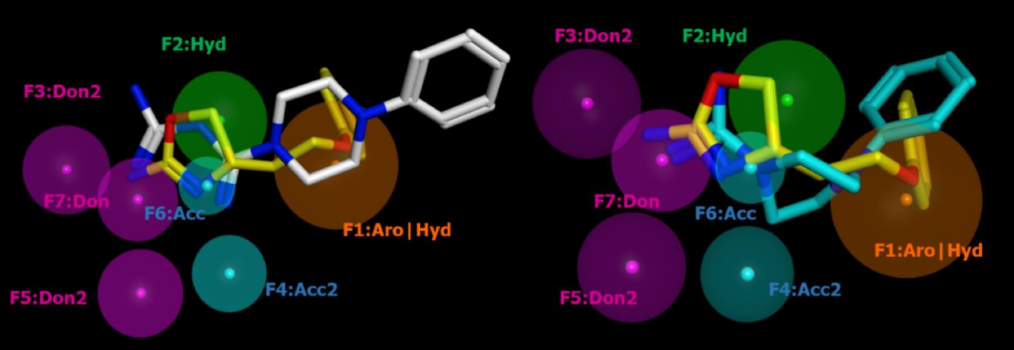
Figure 7. Pharmacophore features shared by most of the oxazolines acting as h TAAR1 agonists (Table S1). The most potent derivative 20b is depicted by bold sticks (colors as in Figure 4). The PM mapping of the in-house developed h TAAR1 agonist 1a ( left ) and the newly designed and synthesized prototype 1 ( right ) are also shown for comparison ( C atoms colored in white and cyan,